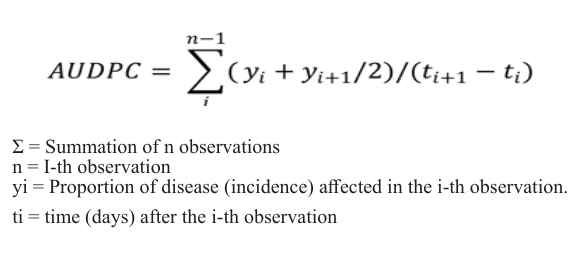
Figure 2. Effect on mycelial growth of chemical and biological fungicides using the poisoned culture